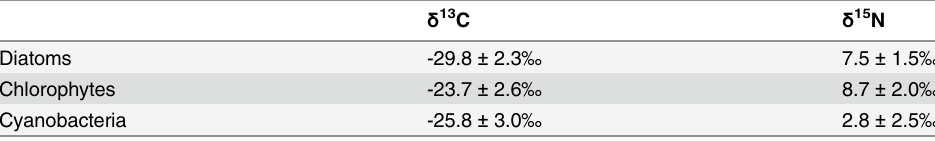
These values re fl ect within lake variation in SI values for the major phytoplankton groups. The reported values are the mean ±